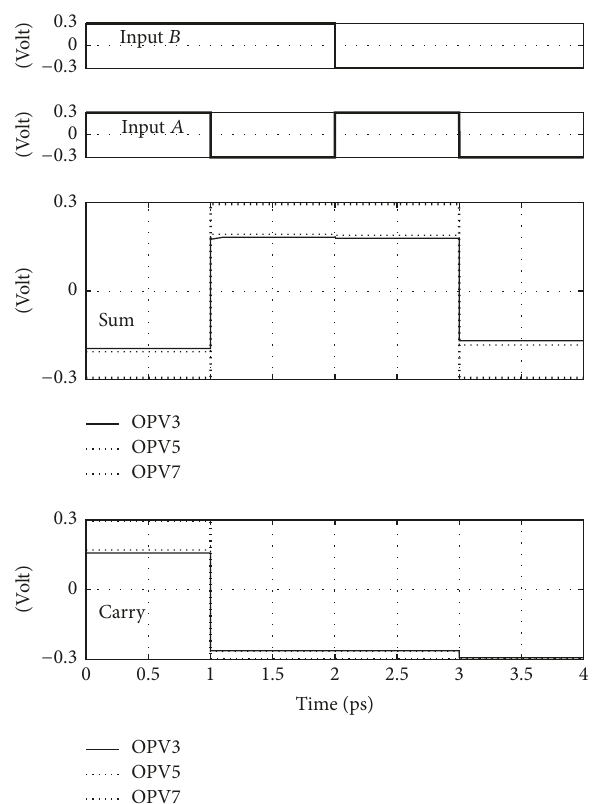
Figure 15: HA waveforms in presence of different molecule